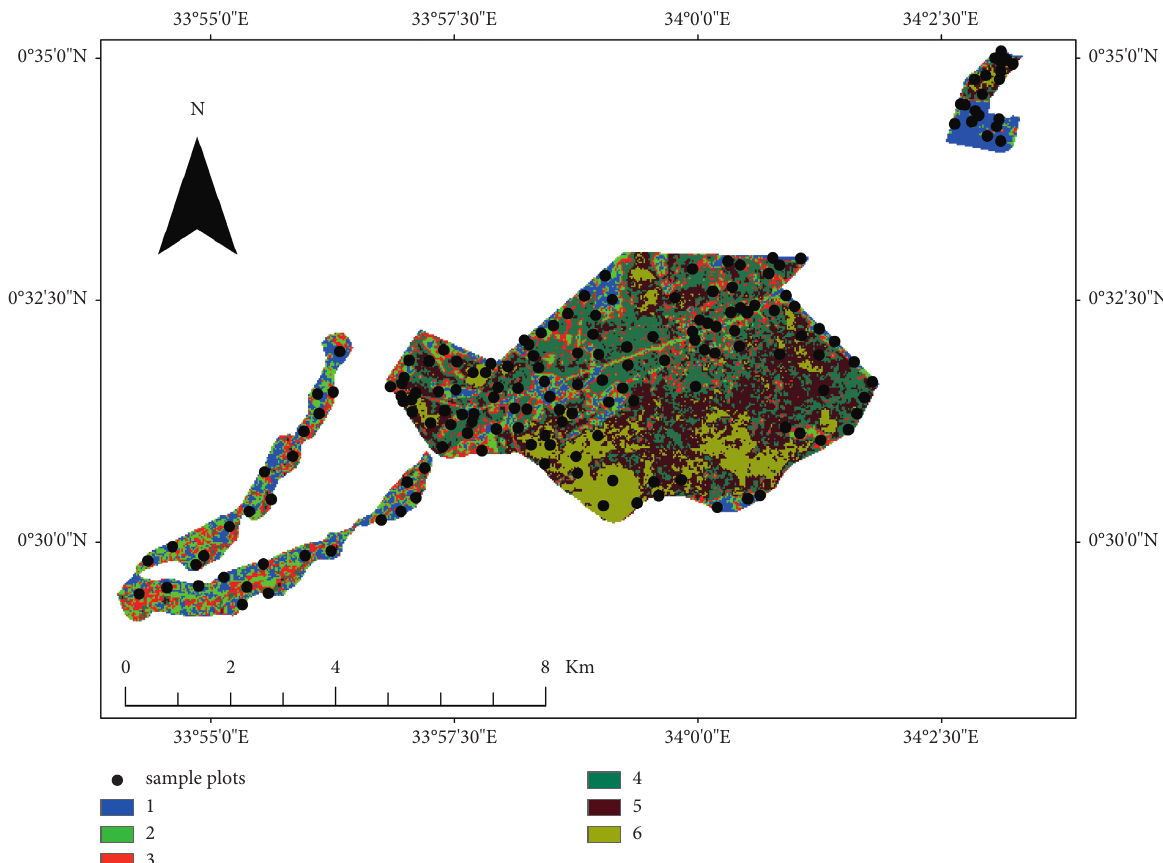
Figure 2: Vegetation sampling strata and distribution of sampling